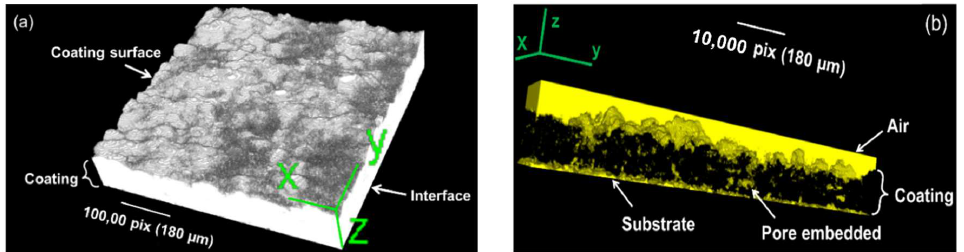
Figure 3. 3D reconstructed views of ( a ) cold sprayed stainless steel coating and ( b ) porosity network.